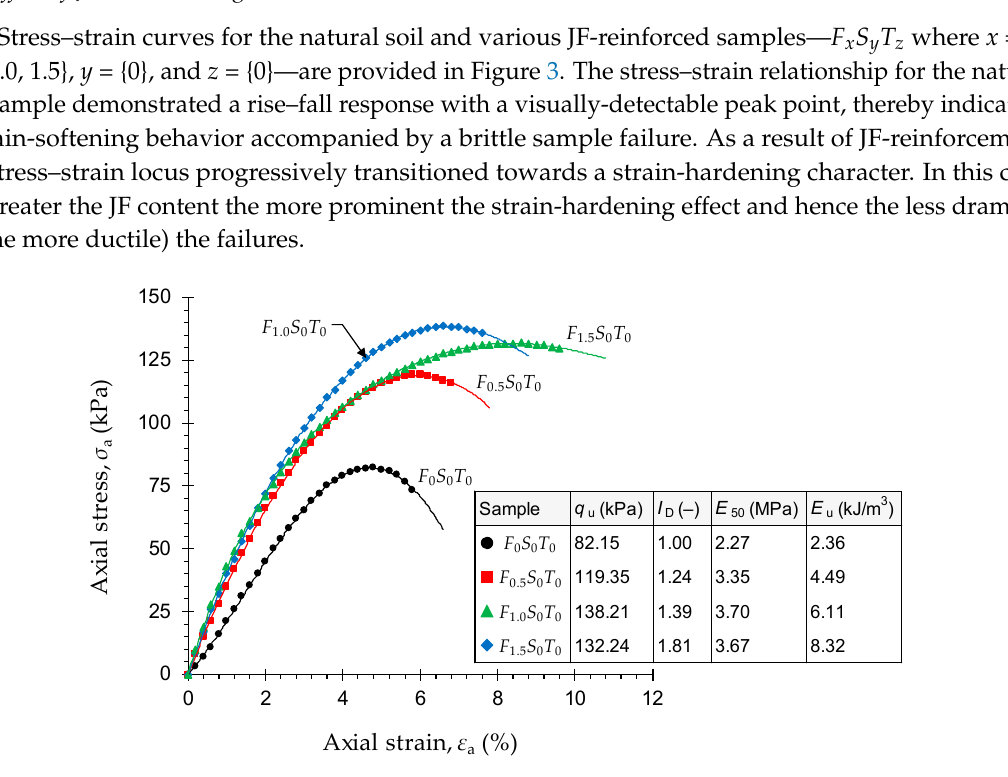
Figure 3. Stress–strain curves for the natural soil and various JF-reinforced samples, i.e., F x S y T z where x = {0, 0.5, 1.0, 1.5}, y = {0}, and z = {0}.